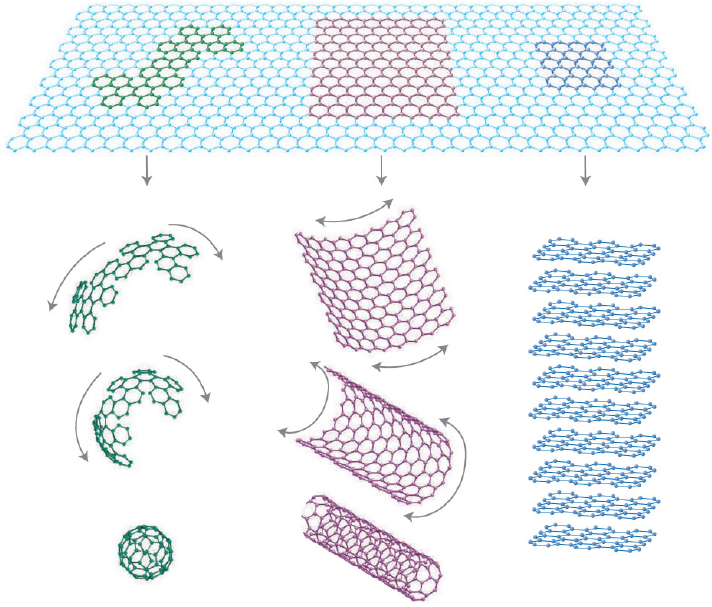
Figure 1. Transformation of two-dimensional graphene into other allotropes such as fullerene, carbon nanotubes, and stacked graphite flakes. Reprinted with permission from reference [18].